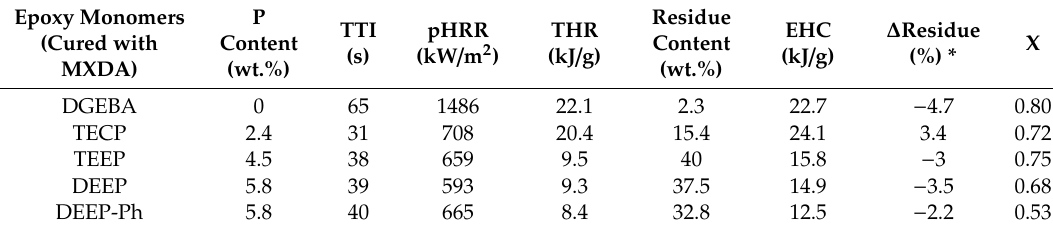
Table 3. Main data from cone calorimeter tests.